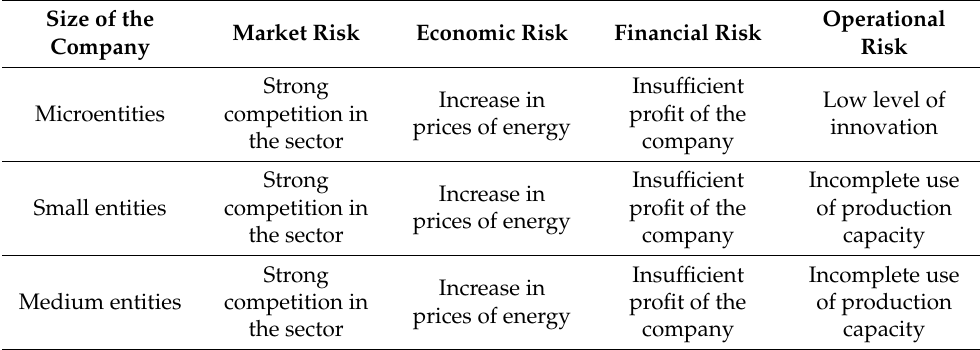
Table 8. Highest risk factors broken down by the size of the company and the percentage of extreme ratings during the COVID-19 pandemic.